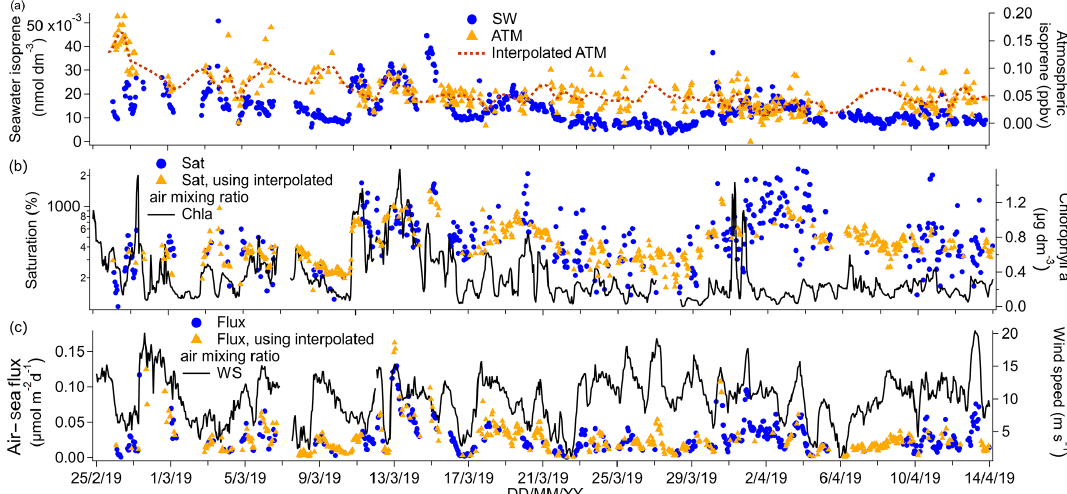
Figure 5. (a) Time series of isoprene seawater (SW) concentrations as well as measured and interpolated marine boundary layer air mixing ratios (ATM and interpolated ATM). (b) Time series of isoprene saturations determined using the measured air mixing ratio and interpolated air mixing ratio and times series of chlorophyll a . (c) Time series of air–sea isoprene fluxes calculated using the measured air mixing ratio and interpolated air mixing ratio and time series of wind